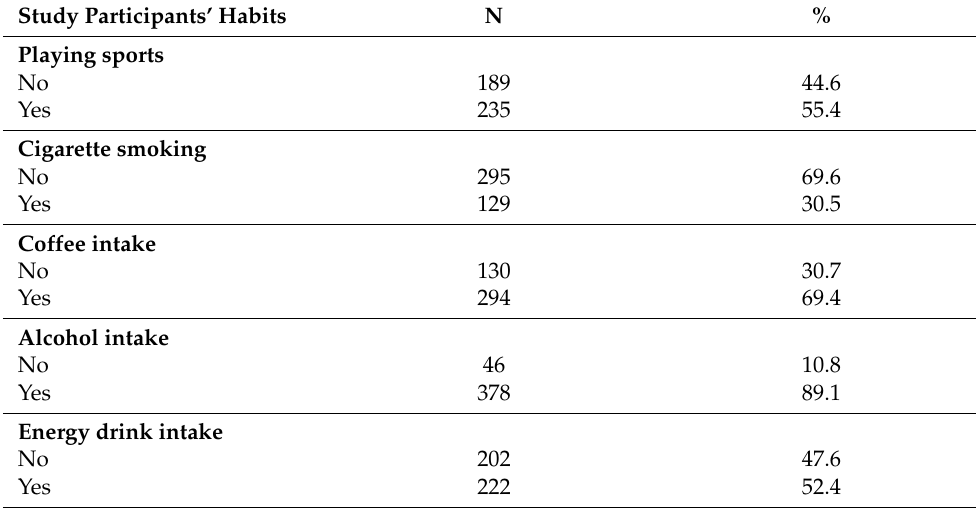
Table 2. Study participants’ habits.